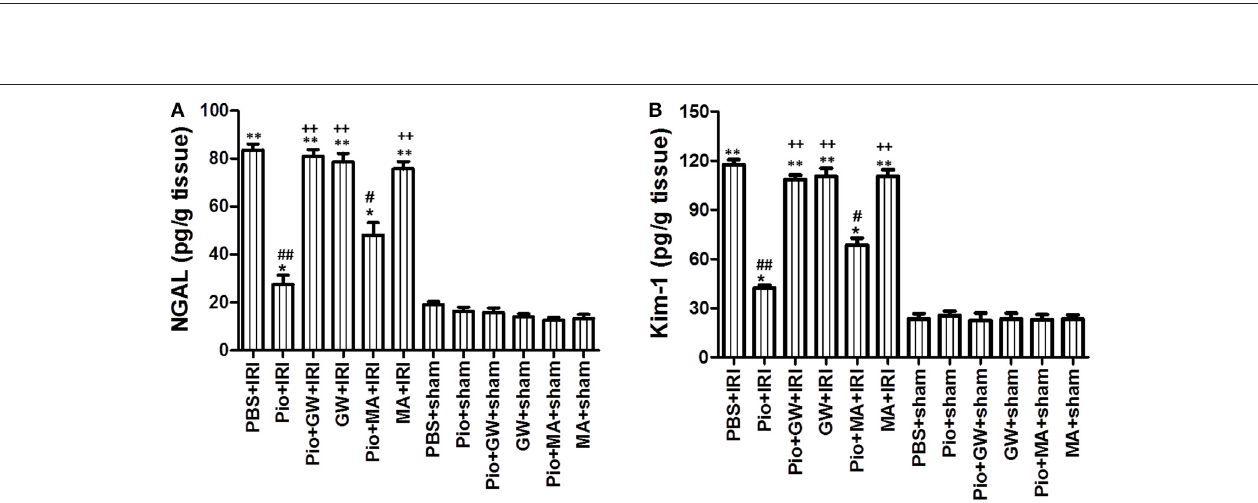
Frontiers in Pharmacology | www.frontiersin.org